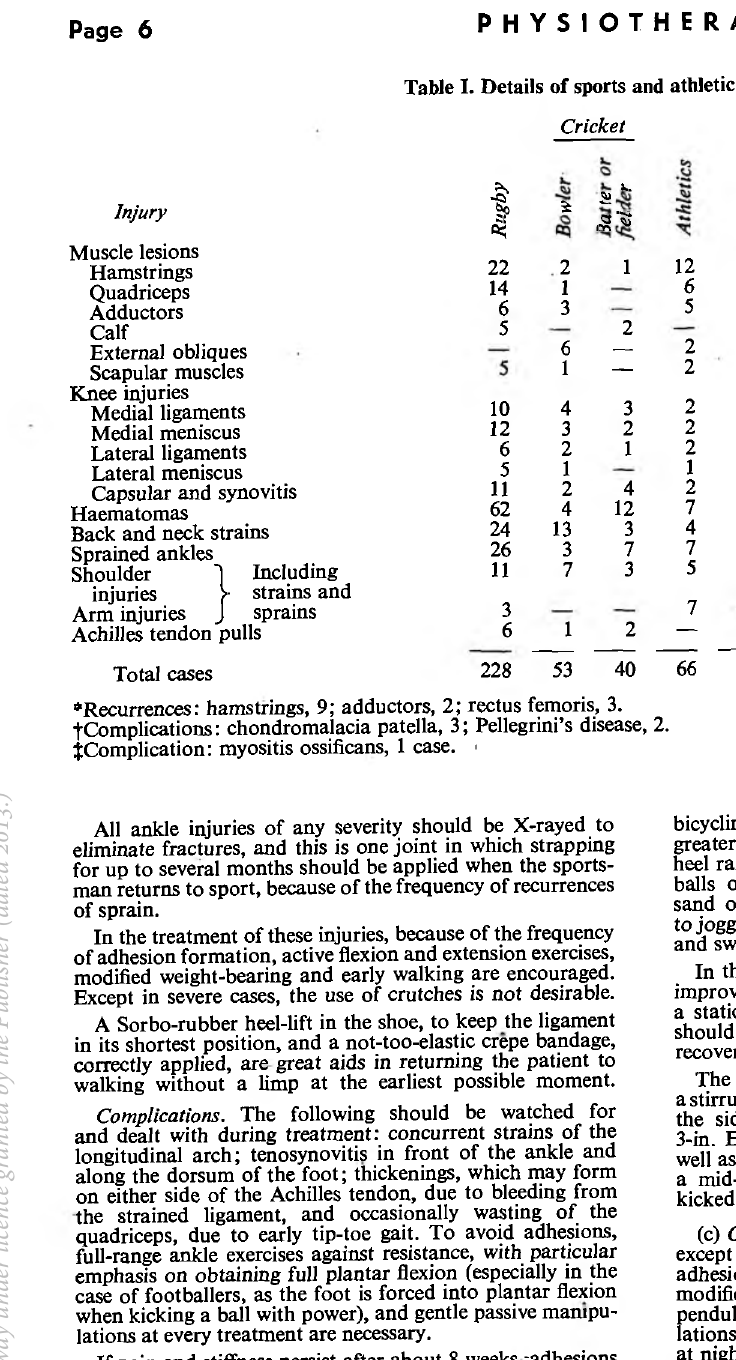
Table I. Details of sports and athletic injuries